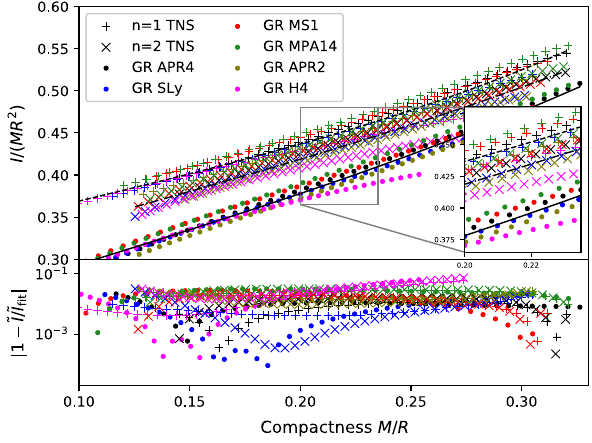
Fig. 7 The normalized moment of inertia ˜ I as a function of the com- pactness for GR and topological neutron stars with a coupling function (12), where we have chosen β = − 0 . 08. Dots show results for GR while pluses and crosses show results for the topological neutron stars of n = 1and n = 2respectively,withthesamecolorschemefortheEOS as in GR. Solid, dashed and dash-dotted lines show the corresponding fits following Eq. (28)